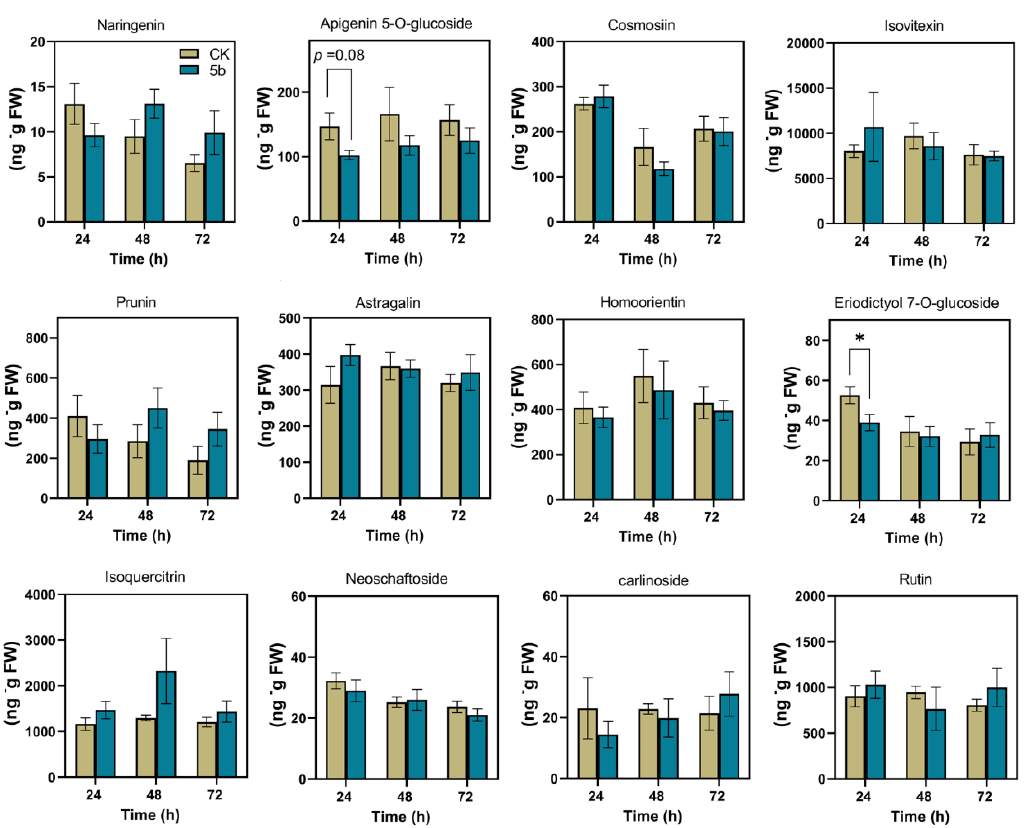
Figure 5. Mean content ( ± SE, n = 5) of 12 flavonoids elicited by JA-Ile-macrolactones. The asterisks indicate a significant difference between treatment and control ( p < 0.05, Student’s t -test).